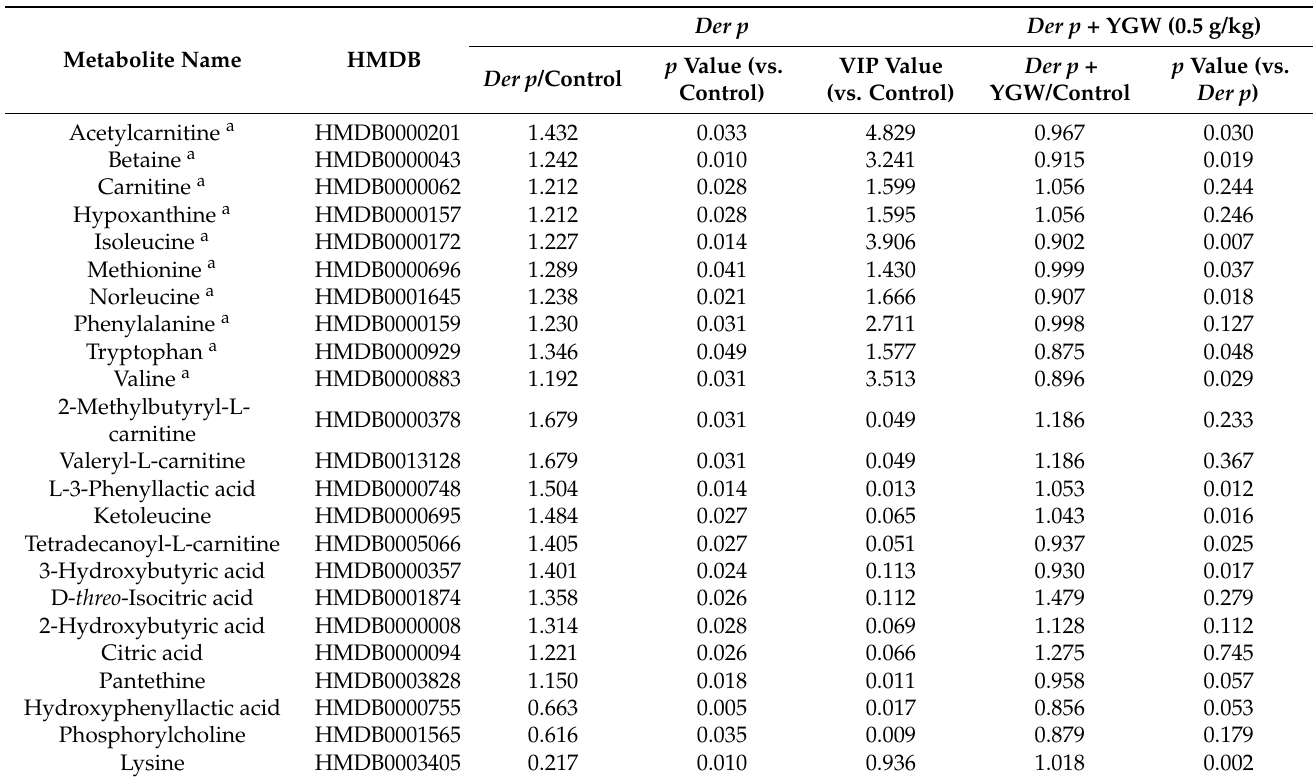
Table 1. Metabolites with significantly changed levels between control and model